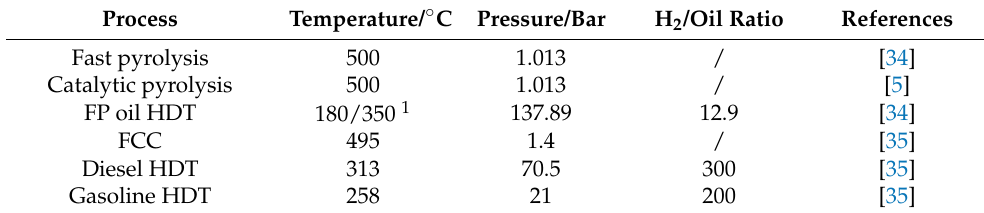
Table 2. Operating parameters of the co-processing scheme.